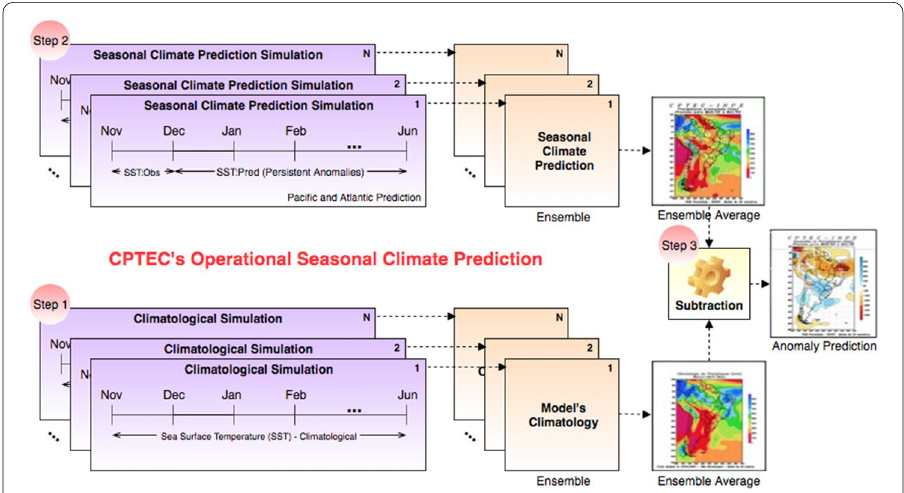
Fig. 3 The operational suite of the CPTEC/INPE seasonal climate prediction